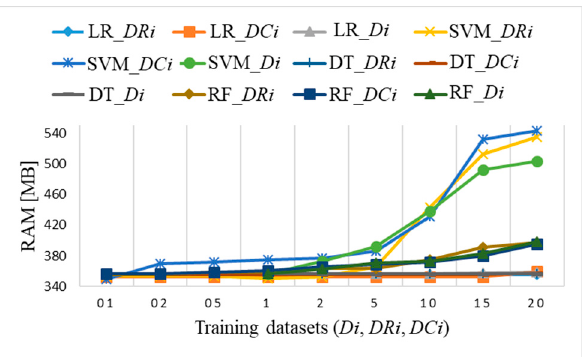
Figure 22. Raspberry Pi 4 memory usage for datasets Di , DRi , DCi with coincidence of LR and DT algorithms RAM usage of 360 MB and with coincidence of RF algorithm with RAM usage for datasets larger than D1, DR1, and DC1 up to 390 MB.